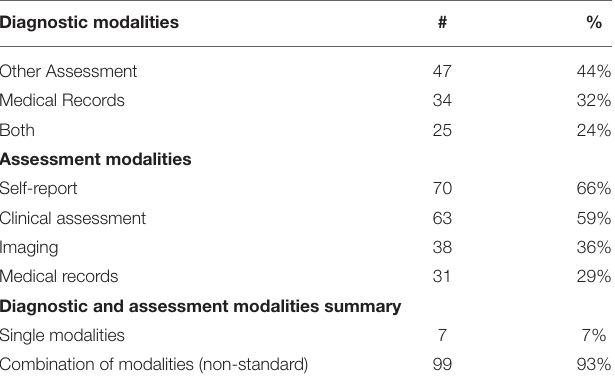
TABLE 6 | Number and percentage of diagnostic and assessment modalities used in the included articles.